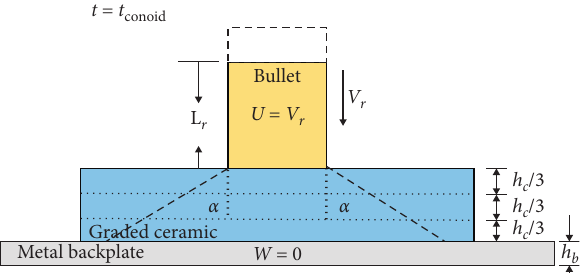
Figure 3: Simplified one-dimensional model of a bullet impacting a ceramic-metal plate when the first stage ends.